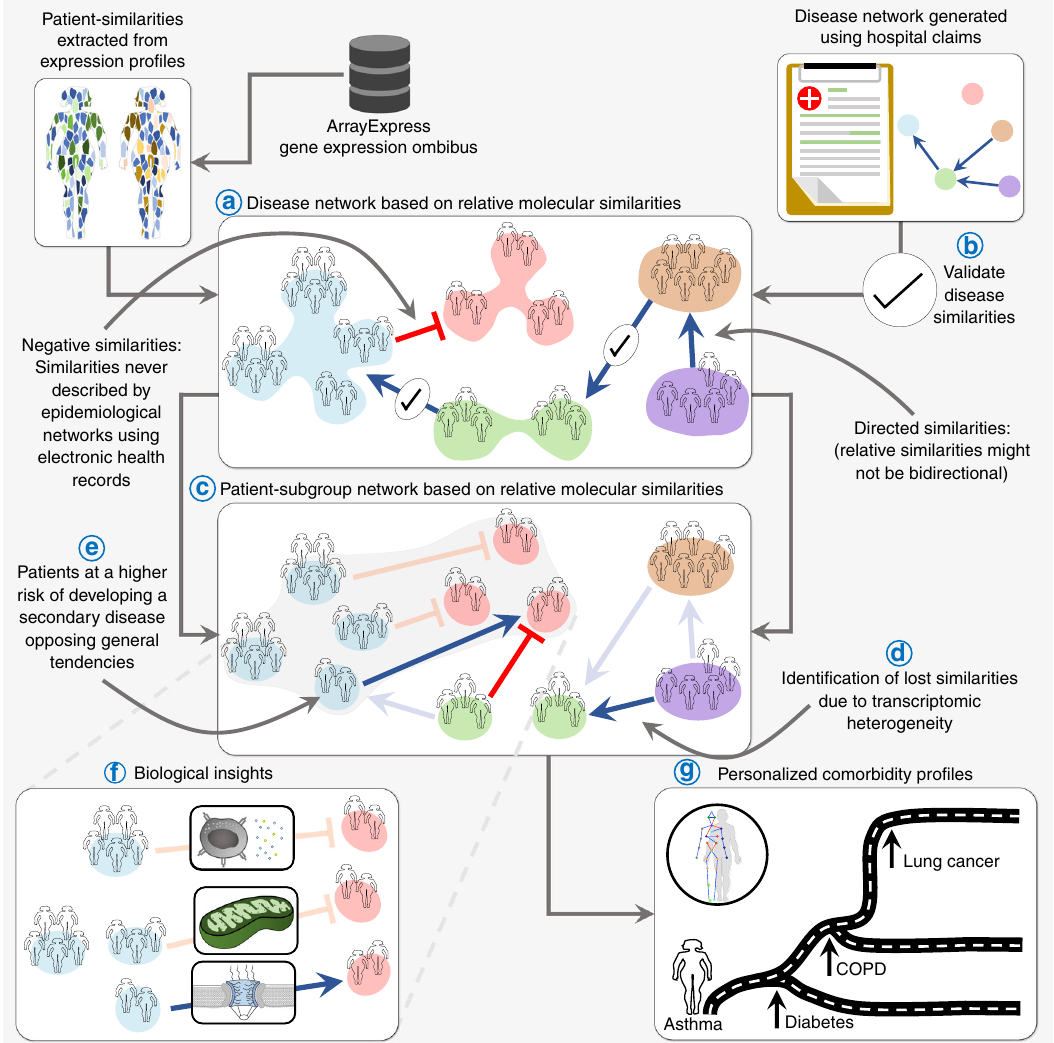
Fig. 1 Main objectives. Throughout the study, we generate a Disease Molecular Similarity Network containing directed positive and negative Relative Molecular Similarity (pRMS and nRMS) interactions ( a ). pRMS are validated using epidemiological networks extracted from medical and hospital claims ( b ). We stratify patients into subgroups and calculate subgroup-speci fi c relative molecular similarities ( c ), identifying similarities that were not recovered when working at the disease level ( d ), including some interactions opposing general trends ( e ). We propose biological processes potentially involved in subgroup-similarities ( f ). Finally, for each single patient, we provide a ranked list of most similar to less similar diseases based on transcriptomics information ( g